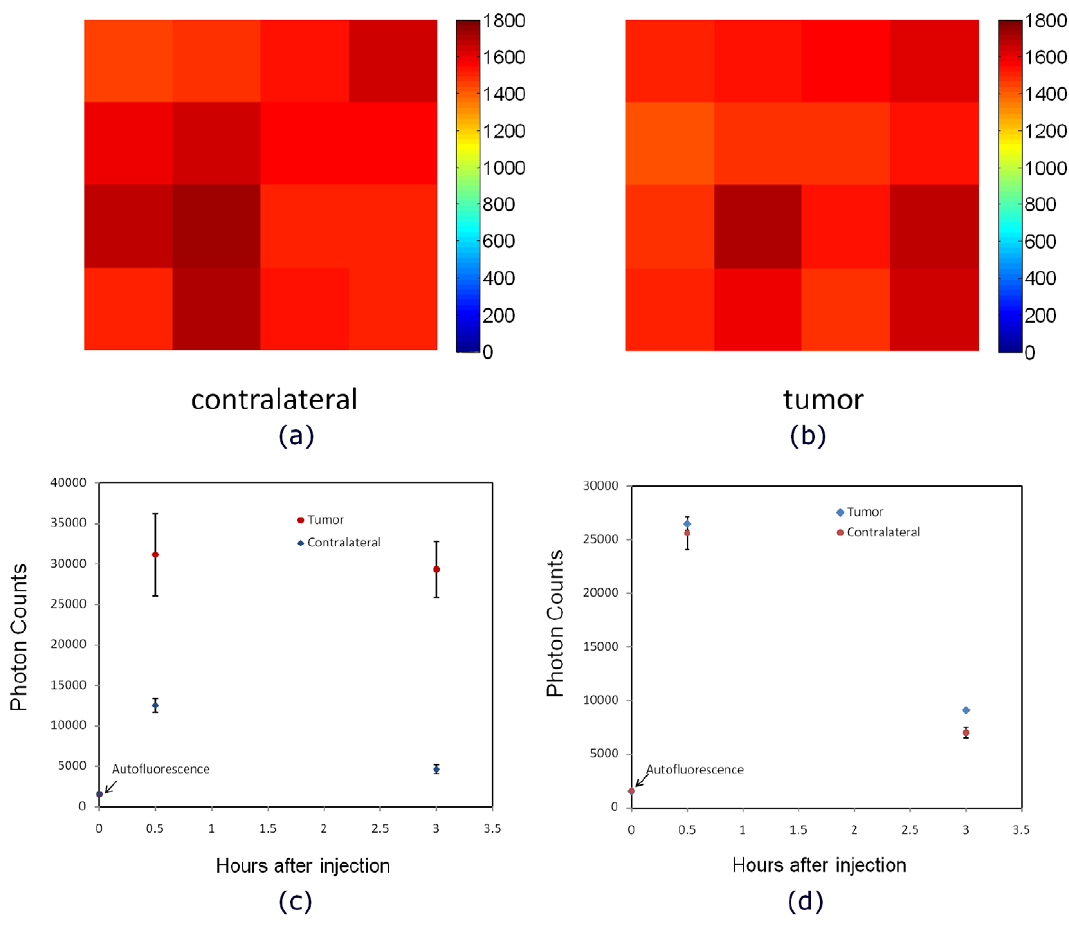
Figure 8. Comparison of autofluorescence intensity at the tumor and contralateral sites. The autofluorescence intensity map at the ( A ) tumor and ( B ) contralateral sites before injection. Comparison of the autofluorescence intensity before injection and the fluorescence signal after injection of ( C ) HER2 specific Affibody-Dylight750 and ( D ) HER2 non-specific Affibody-Dylight750 in 3 mice with HER2 positive tumor (NCI-N87 tumor carcinoma) at the tumor and contralateral sites .